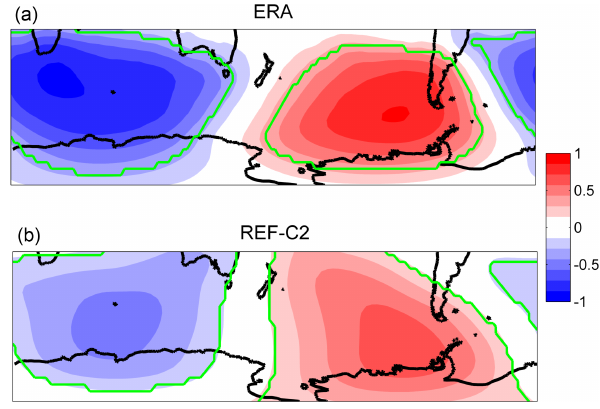
with the 50hPa temperature for the ERA-Interim reanalysis (a) and model (b)